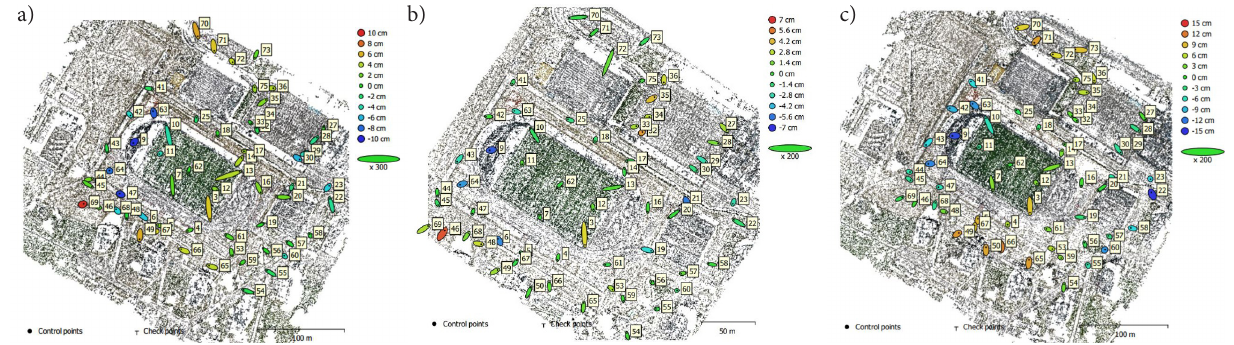
Figure 6. Distribution of model fitting errors on ground control points for the variant: a – vertical images; b – oblique images; c – combination of vertical and oblique